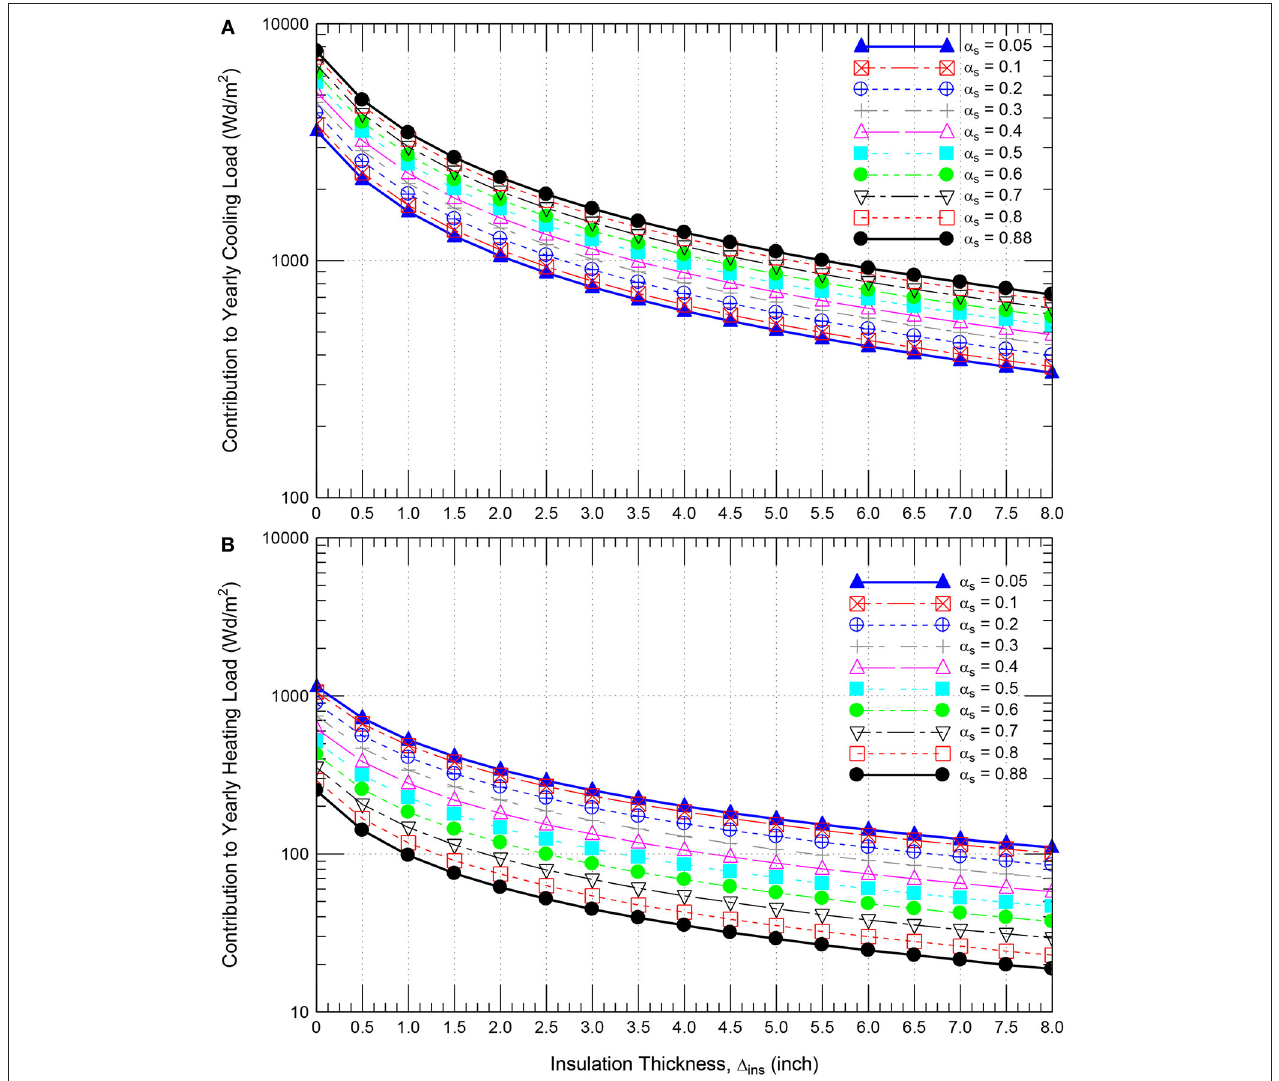
FIGURE 14 | Effect of the insulation thickness on the contribution to yearly cooling energy load (A) and yearly heating energy load (B) (in log scale) for different short-wave solar absorption coefficients.